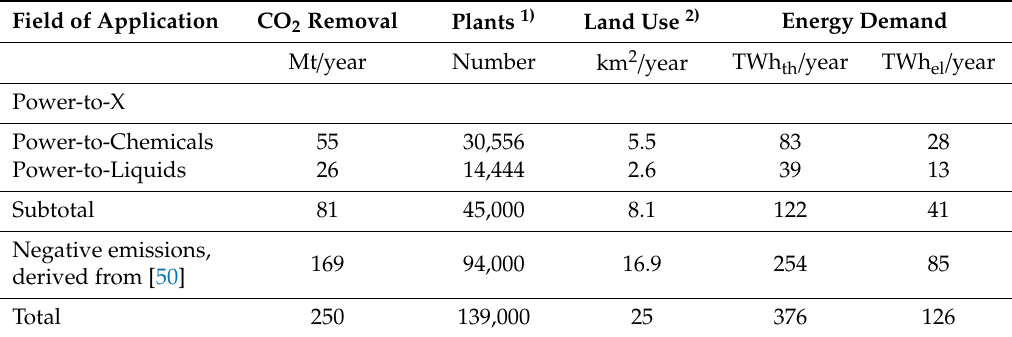
Table 7. Sample estimation of the use of land and energy for Direct Air Capture (DAC) plants to provide CO 2 for both Power-to-Liquids (PtL) and Power-to-Chemicals (PtC) in Germany and as a possible German share of negative emissions in the year 2050 (own calculation; plant parameters based on